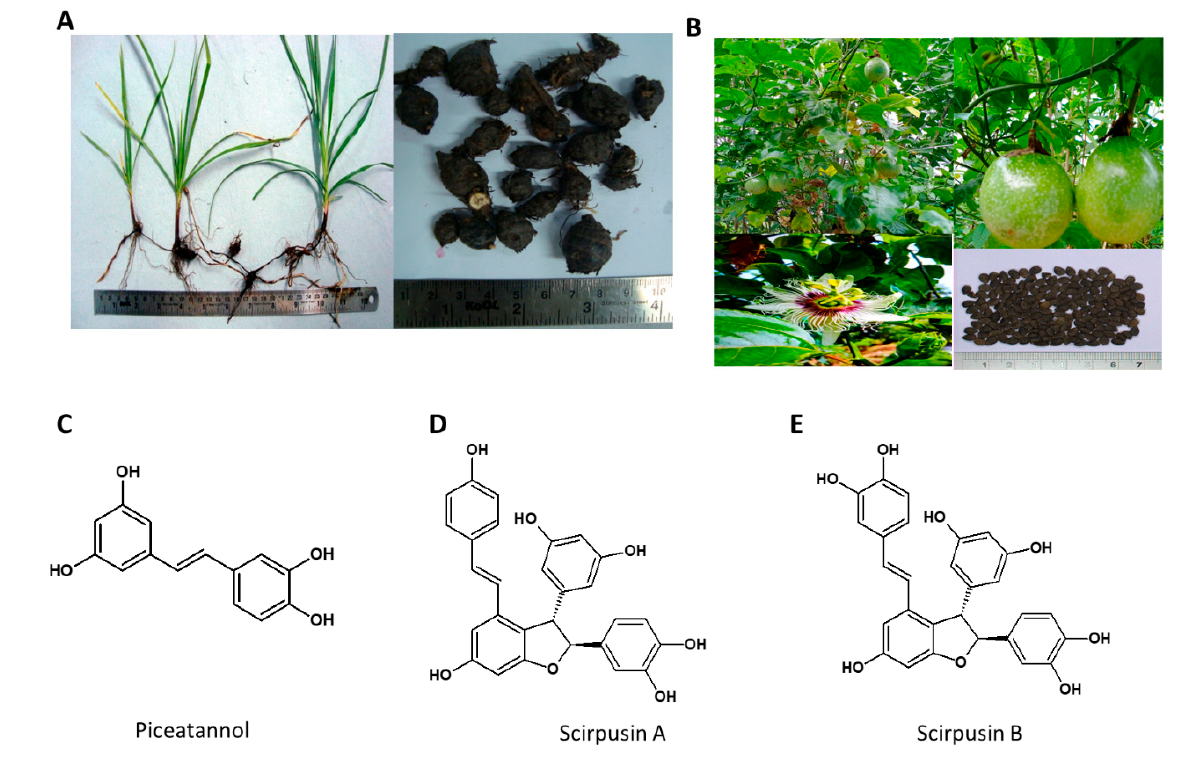
Figure 5. ( A ) Cyperus rotundus . Habit of the Plant, and Enlarged view of rhizomes. ( B ) Passiflora edulis ; habit, enlarged fruit, flower and seeds, ( C ) Piceatannol, ( D ) Scirpusin A, ( E ) Scirpusin B.